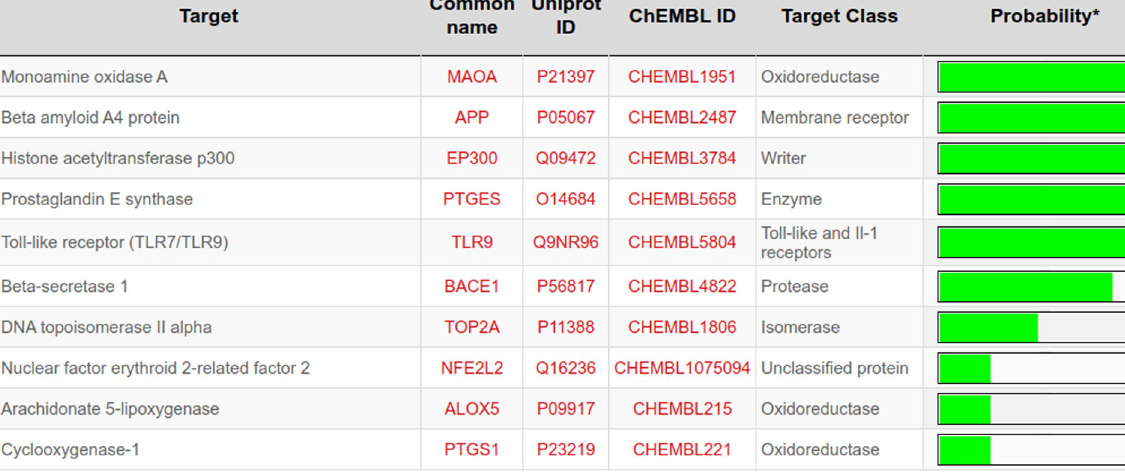
PLOS ONE | https://doi.org/10.1371/journal.pone.0270123 June 29,